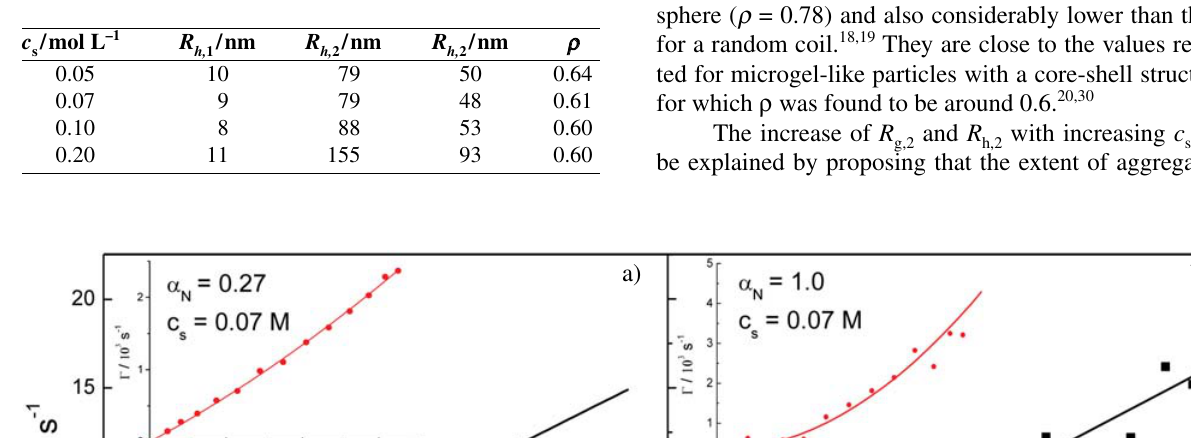
, R , R ) and the shape parame- h,1 h,2 g,2 = 0.27 and c N . The uncertainty in R s